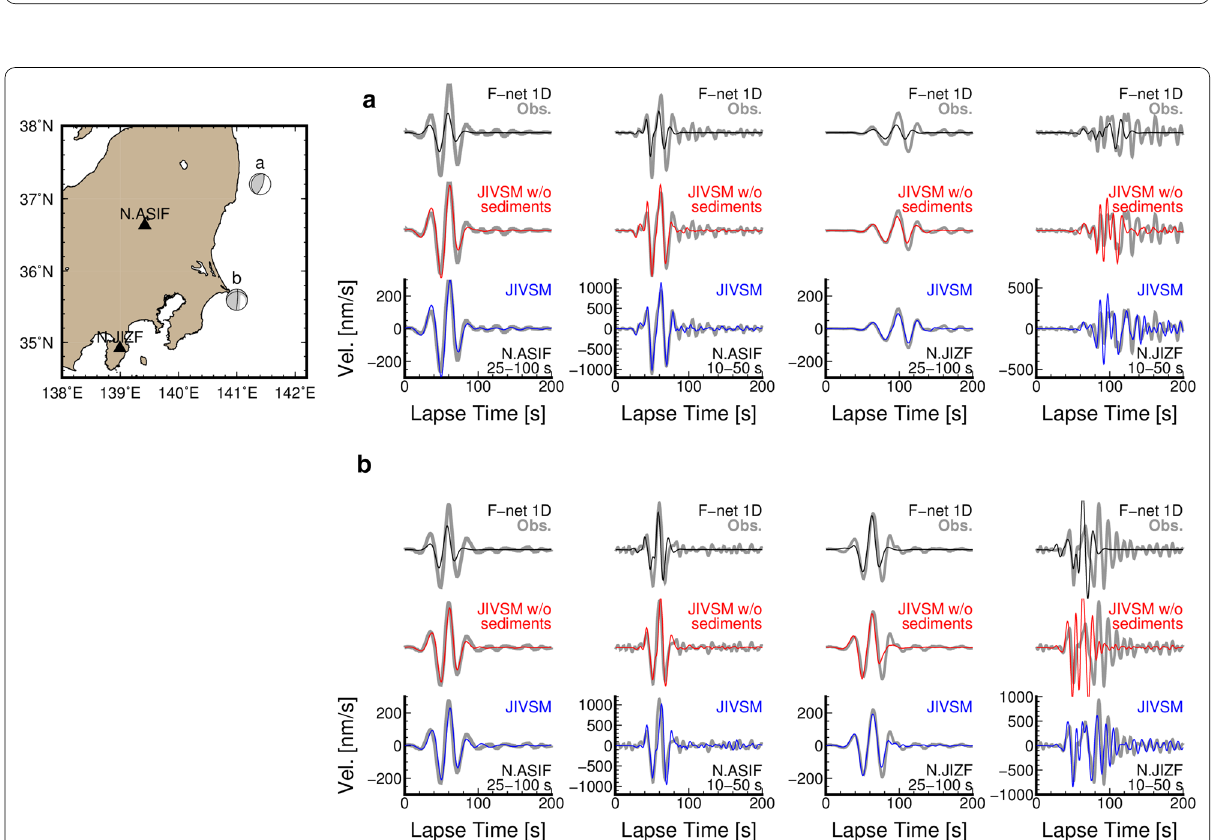
Fig. 5 Differences in Mw values between F-net MT and 3D CMT solutions along the Nankai Trough. The 3D CMT catalog along the Nankai Trough was referred from Takemura et al. (2020)